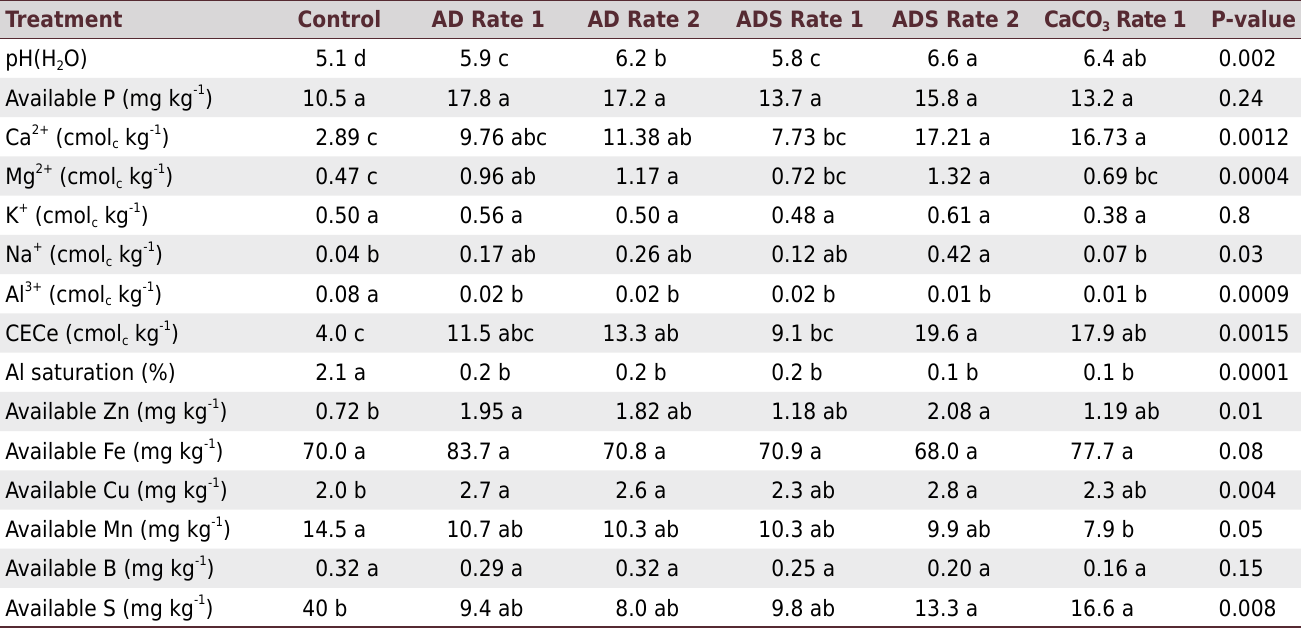
Table 4. Soil chemical properties at the Carillanca location 360 days after the application of six soil acidity control treatments